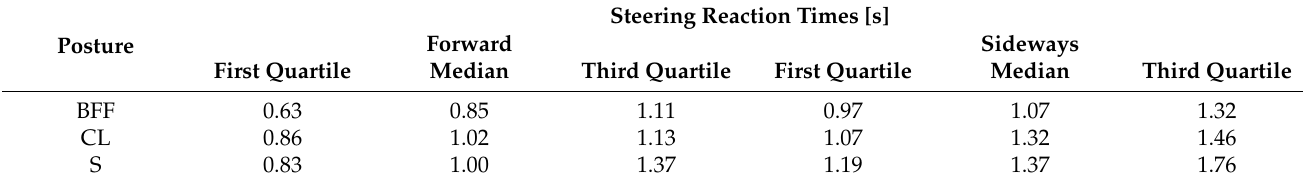
Table 6. Quartile table of steering reaction times.